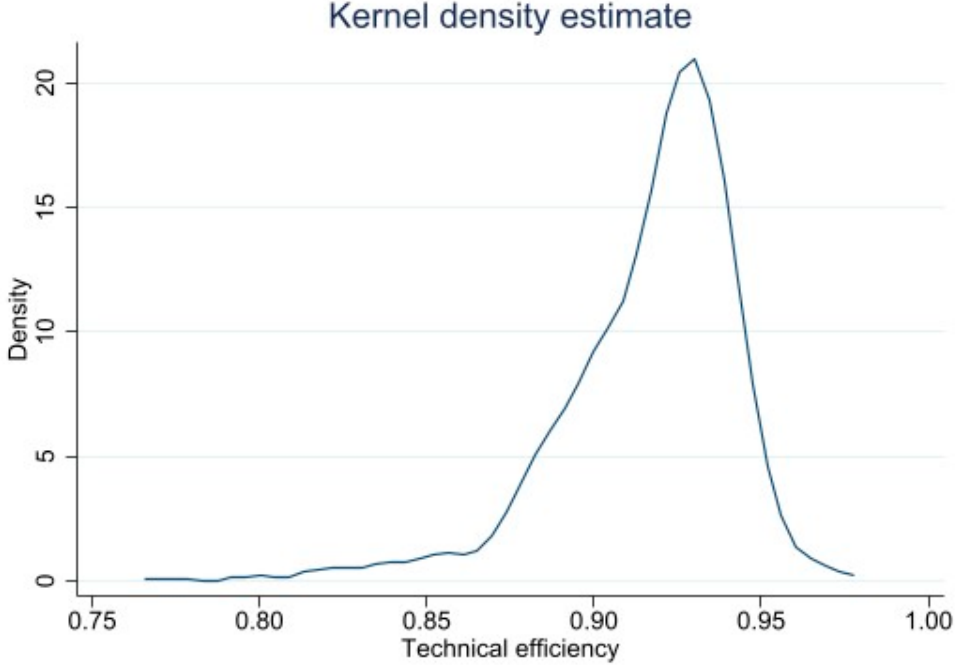
Figure 1. Kernel density distribution of technical efficiency.